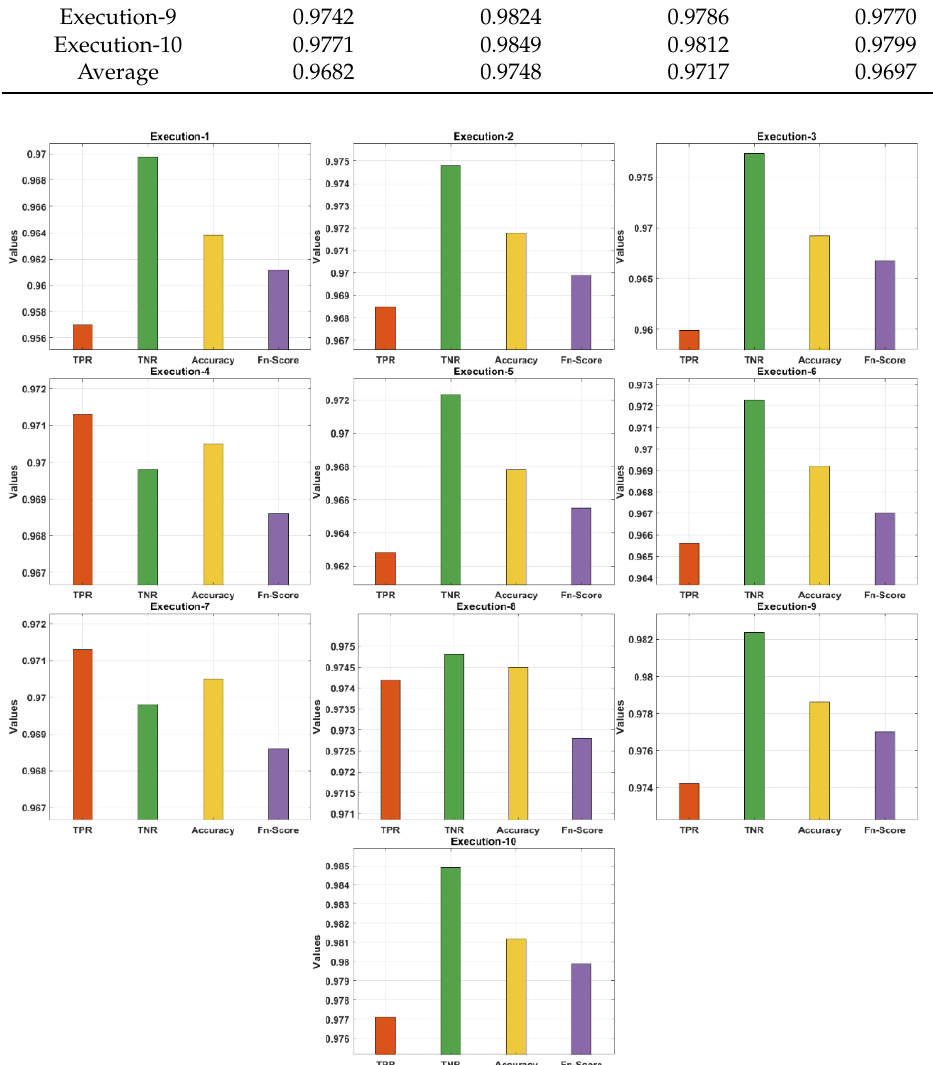
Figure 5. Result analysis of AIEM-DC model with different measures. Table 1. Results analysis of proposed AIEM-DC model in terms of various measures.